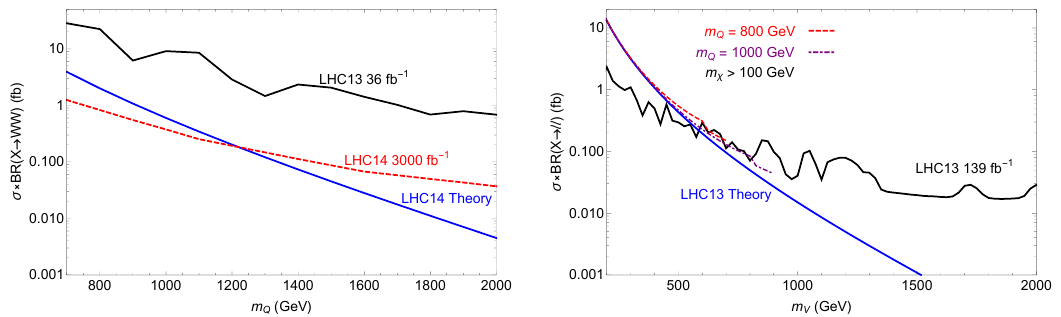
T (cid:0) quirks dominant decays are into weak gauge bosons W + W (cid:0) . The dominant X and Y is into hidden gluons. b b b